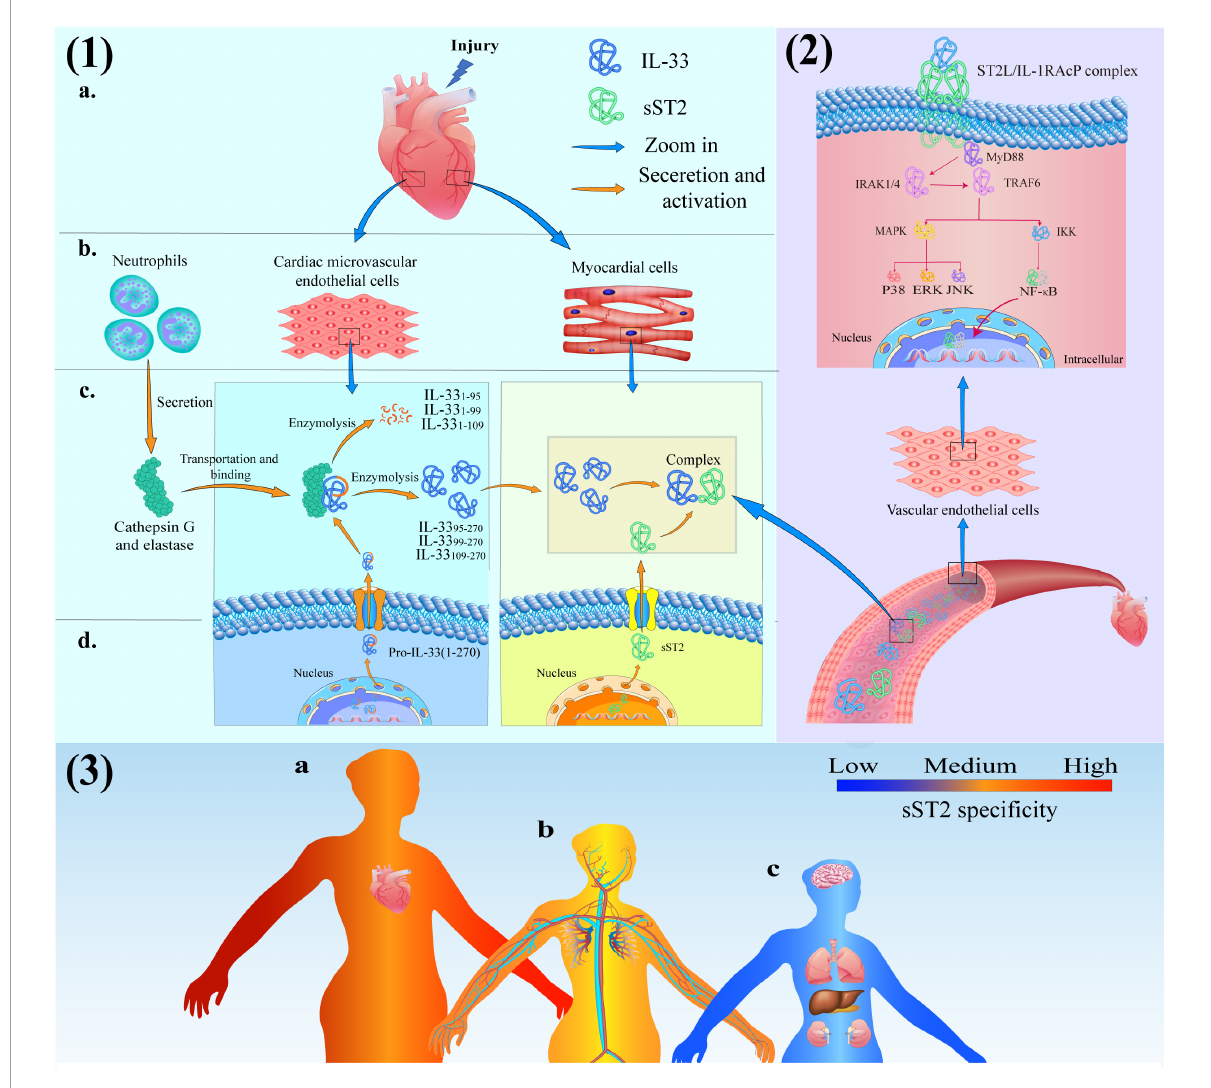
FIGURE2 (1) Production and activation of IL-33 and soluble growth stimulation expressed gene 2 (sST2) protein in cardiac tissue consisted of (a) heart, (b) cells, (c) intercellular substance and (d) intracellular; (2) The IL-33/ST2 signaling pathway in Blood vessels; (3) The schematic diagram of sST2-related diseases: (a) Red-heart disease closely related to sST2 (high specificity); (b) Yellow-vascular diseases moderately correlated with sST2 (medium specificity) and (c) Bule-the diseases have limited association with sST2 (low